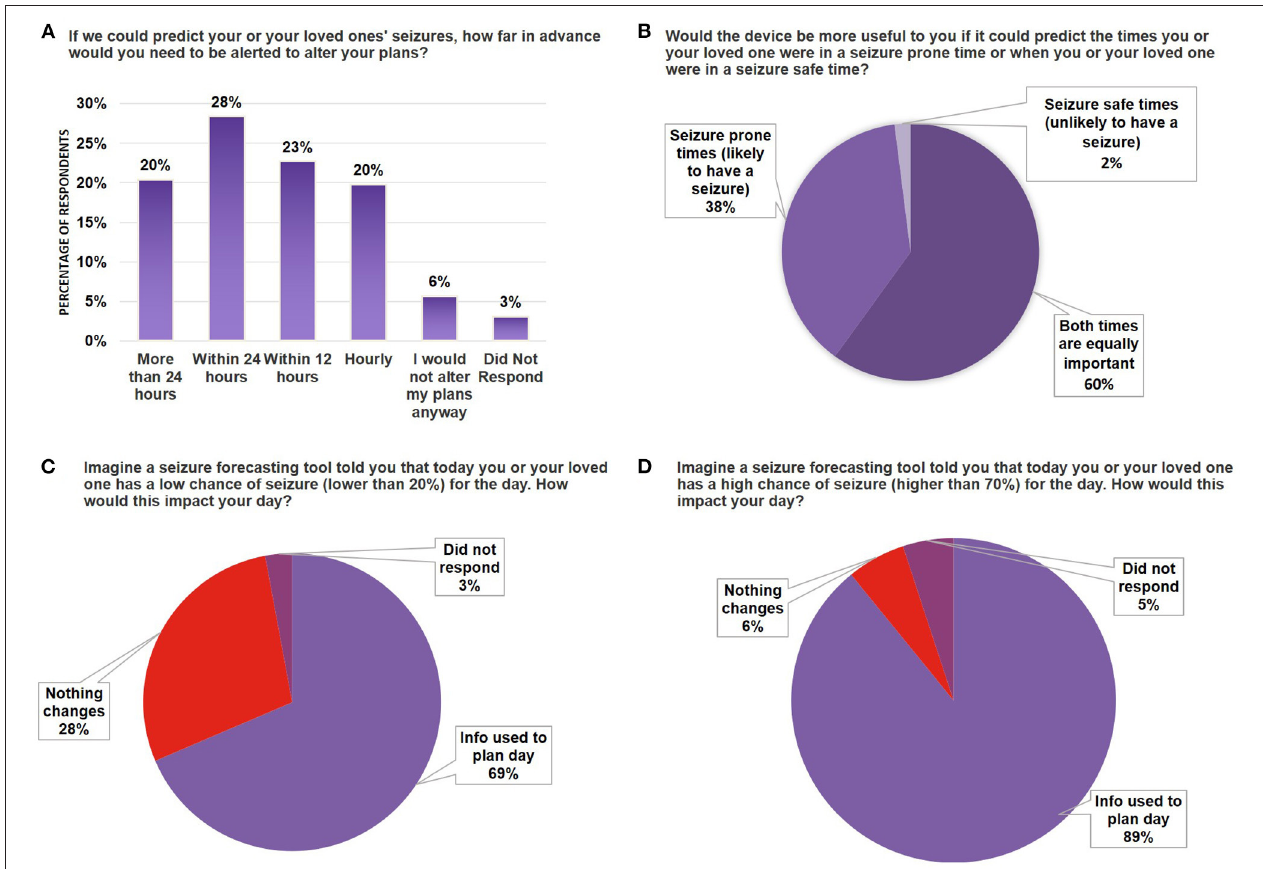
FIGURE 3 | Seizure forecasting device scenario testing. (A) Bar graph indicating the breakdown by percentage of survey respondents who wanted to be alerted at different time scales for their likelihood of seizure (time ranges indicated on X-axis). (B) Pie chart breaking down the percentage of respondents who indicated whether they had a preference to use a device that would forecast seizure-prone vs. seizure-safe states. (C,D) Bar graph indicating the percentage of survey respondents that would use the device in daily planning when the device forecasted a 20% chance of seizure (C) or 70% chance of seizure (D) . Note that all numbers have been rounded to two significant figures. No significant differences were found between segments using the Mann-Whitney U